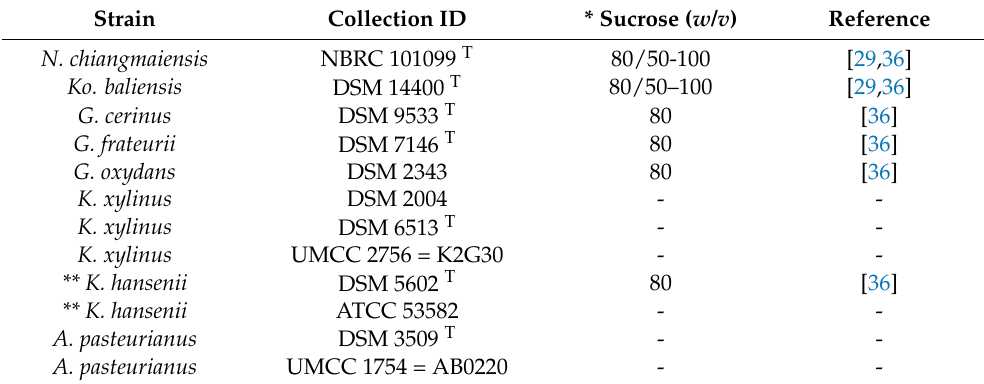
Table 1. List of AAB strains tested in this study.